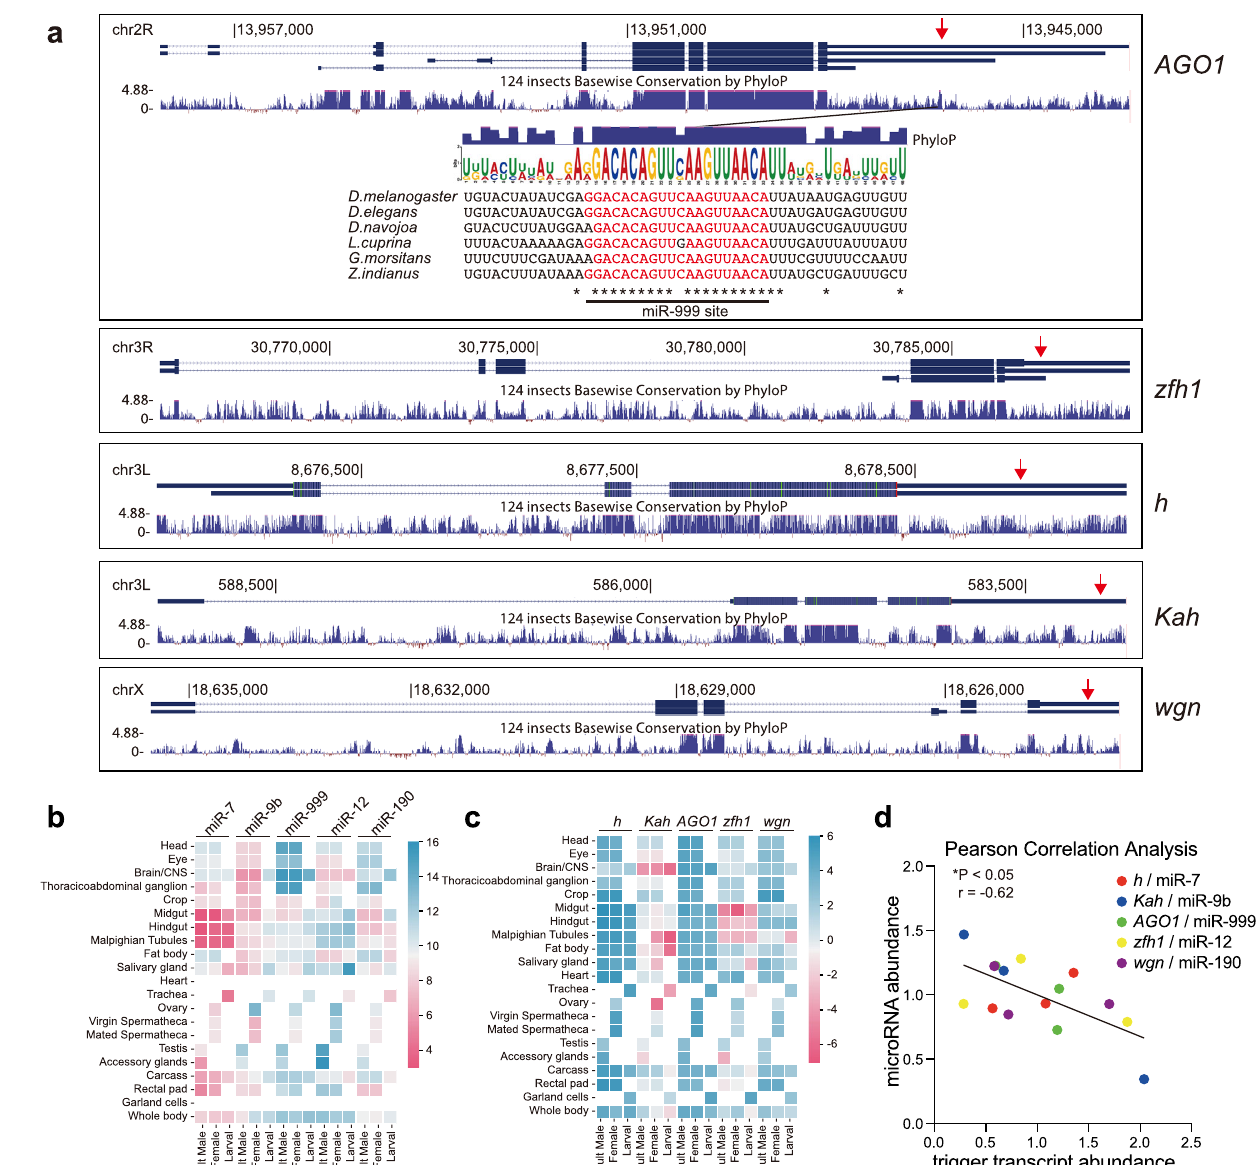
Fig. 2 | Evaluation of the high-con fi dence TDMD triggers. a Genome browser view of trigger transcript models (blue boxes, exons; blue line, introns) with alternative isoforms and conservation plots, which are based on a 124 insects BasewiseConservationbyPhyloP(phyloP124way).Thetranscriptsareshowninthe 5 ′ to 3 ′ direction. Red arrows point to the TDMD triggers. Diagramed below AGO1 transcriptisthe trigger site against miR-999 (in red), fl anked by 15 nt on each side. The sequence logo based on six homologous sequences is shown from the indi- cated species. Asterisks indicate bases conserved in all of the representative